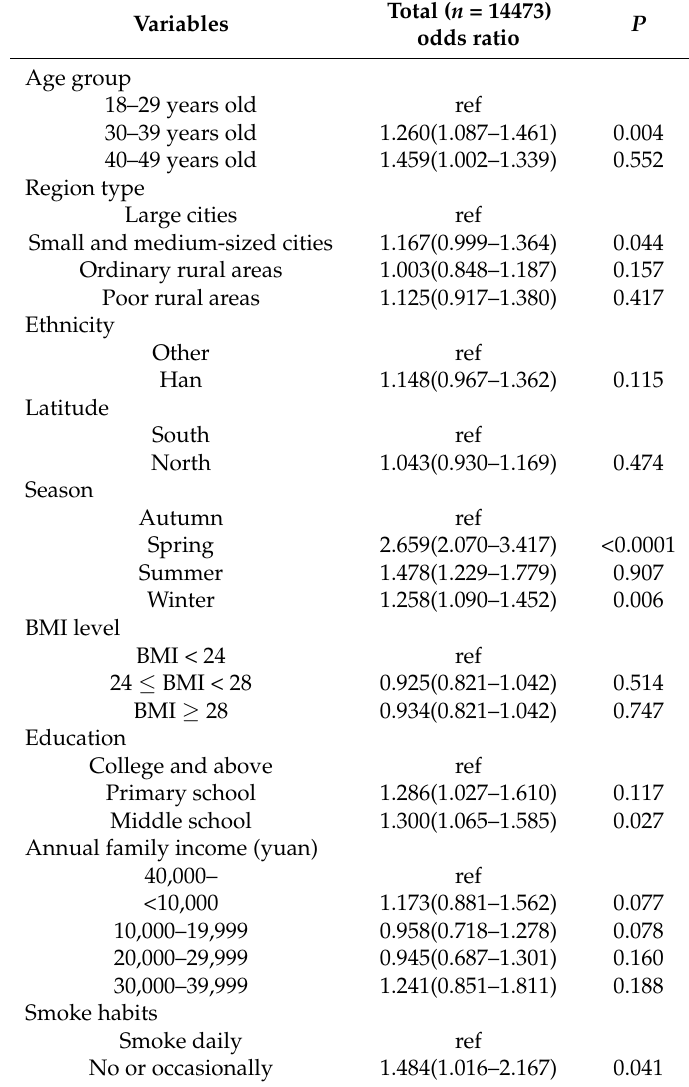
Table 2. Determinants of anemia among Chinese childbearing women from Chinese National Nutrition and Health Survey 2010–2012 (logistic